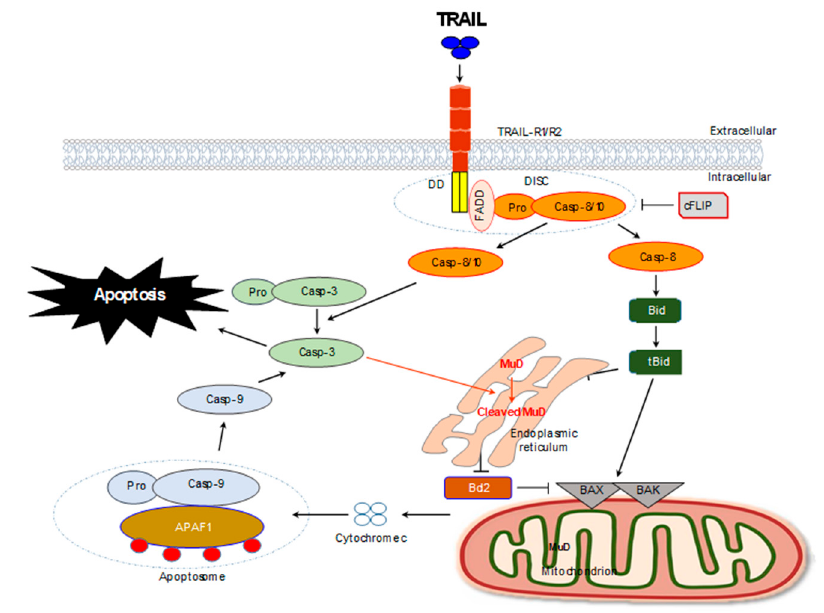
Figure 2. TRAIL-mediated apoptotic signaling pathway overview: Binding of TRAIL to cognate TRAIL Figure 2. TRAIL ‐ mediated apoptotic signaling pathway overview: Binding of TRAIL to cognate receptor, TRAIL-R1 / 2 results in receptor oligomerization and recruitment of Fas-associated protein with TRAIL receptor, TRAIL ‐ R1/2 results in receptor oligomerization and recruitment of Fas ‐ associated death domain (FADD) and caspase-8 to form a functional death-inducing signaling complex (DISC). protein with death domain (FADD) and caspase ‐ 8 to form a functional death ‐ inducing signaling Upon DISC formation, caspase-8 / -10 is cleaved and activated, which in turn can cleave and activate complex (DISC). Upon DISC formation, caspase ‐ 8/ ‐ 10 is cleaved and activated, which in turn can caspase-3 and the BH3-only protein Bid. Active, cleaved BID (tBid) can bind to pro-apoptotic BAX and cleave and activate caspase ‐ 3 and the BH3 ‐ only protein Bid. Active, cleaved BID (tBid) can bind to BAK, resulting in mitochondrial membrane permeabilization and release of mitochondrial proteins pro ‐ apoptotic BAX and BAK, resulting in mitochondrial membrane permeabilization and release of cytochrome c. Cytochrome c, apoptotic protease-activating factor 1 (APAF1) and caspase-9 combine mitochondrial proteins cytochrome c. Cytochrome c, apoptotic protease ‐ activating factor 1 (APAF1) with ATP to form a functional apoptosome that results in cleavage and activation of caspase-9, which can then cleave caspase-3. Caspase-3 can cleave a large number of intracellular targets resulting in the and caspase ‐ 9 combine with ATP to form a functional apoptosome that results in cleavage and morphological and biochemical hallmarks of apoptosis (Stuckey and Shah, 2013 [63]). Upon TRAIL activation of caspase ‐ 9, which can then cleave caspase ‐ 3. Caspase ‐ 3 can cleave a large number of stimulation, MuD activation by caspase-3 occurs prior to Bcl-2 cleavage and Bid may be essential for intracellular targets resulting in the morphological and biochemical hallmarks of apoptosis (Stuckey the regulation of MuD expression and function upon TRAIL stimulation. Abbreviations: TRAIL, tumor and Shah, 2013 [63]). Upon TRAIL stimulation, MuD activation by caspase ‐ 3 occurs prior to Bcl ‐ 2 necrosis factor (TNF)-related apoptosis-inducing ligand; APAF-1, apoptotic protease activating factor-1; cleavage and Bid may be essential for the regulation of MuD expression and function upon TRAIL Bid; BH3-interacting domain death agonist; Bcl-2, B cell chronic lymphocytic leukemia / lymphoma 2; stimulation. Abbreviations: TRAIL, tumor necrosis factor (TNF) ‐ related apoptosis ‐ inducing ligand; BAK, Bcl-2 homologous antagonist / killer; BAX, Bcl-2-associated protein; FADD, Fas-associated death APAF ‐ 1, apoptotic protease activating factor ‐ 1; Bid; BH3 ‐ interacting domain death agonist; Bcl ‐ 2, B domain; cFLIP, cellular FLICE-inhibitory protein; DISC, death-inducing signaling cell chronic lymphocytic leukemia/lymphoma 2; BAK, Bcl ‐ 2 homologous antagonist/killer; BAX, Bcl ‐ 2 ‐ associated protein; FADD, Fas ‐ associated death domain; cFLIP, cellular FLICE ‐ inhibitory protein; DISC, death ‐ inducing signaling complex.